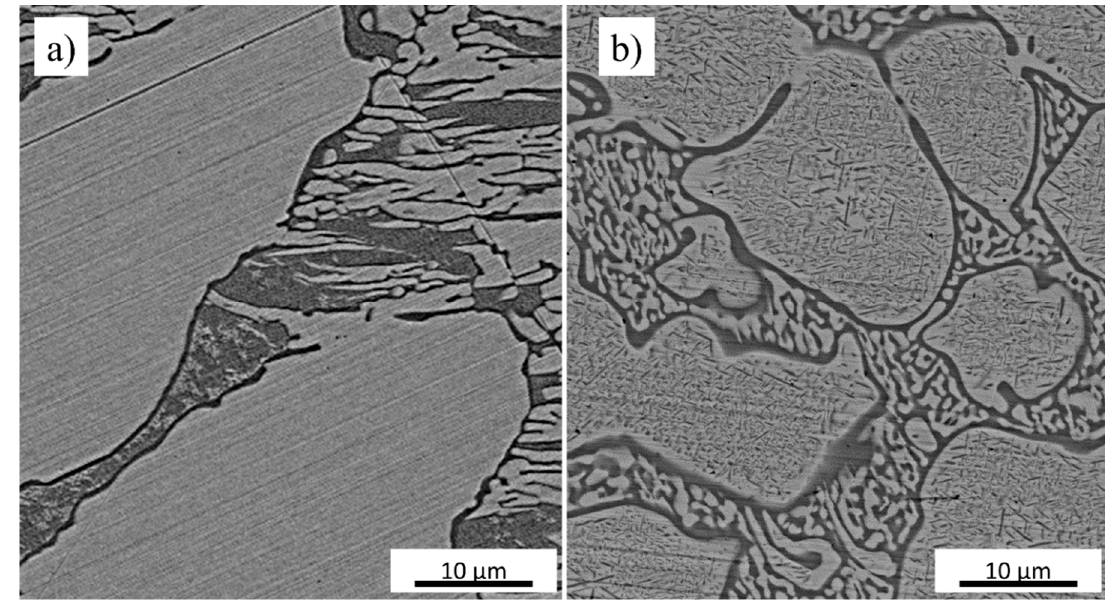
Figure 4. High-magnification BSE SEM-micrographs of Al 0.6 in its as-cast state ( a ) and after heat treatment at T = 800 °C ( b ).